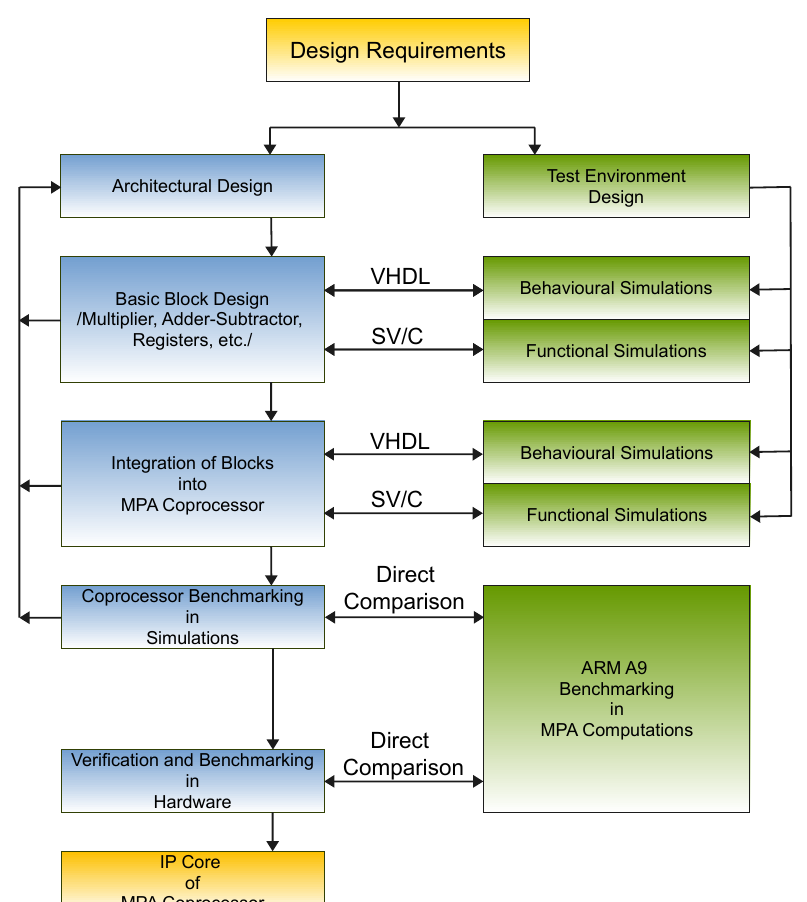
Figure 14. Design flow of MPA